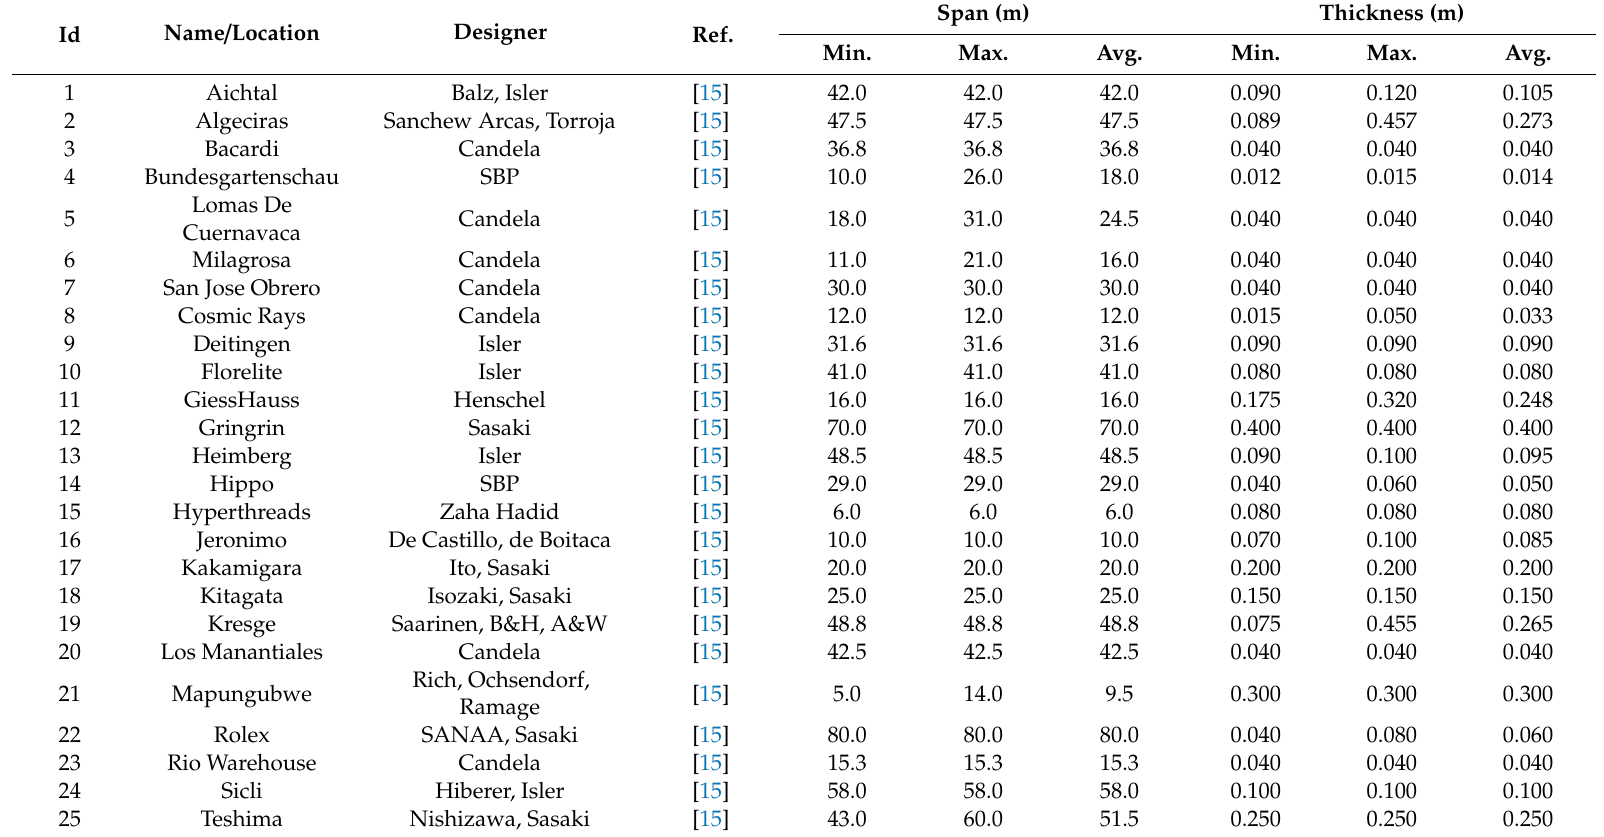
Table A2. Dimensions of large scale engineered thin shells included in the study. The structures are described in